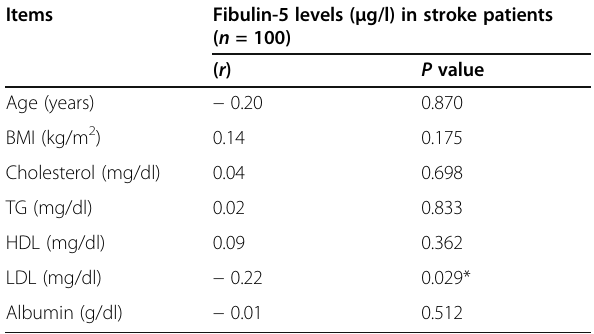
Table 5 Correlations between fibulin-5 levels with clinical characteristics and laboratory data in stroke